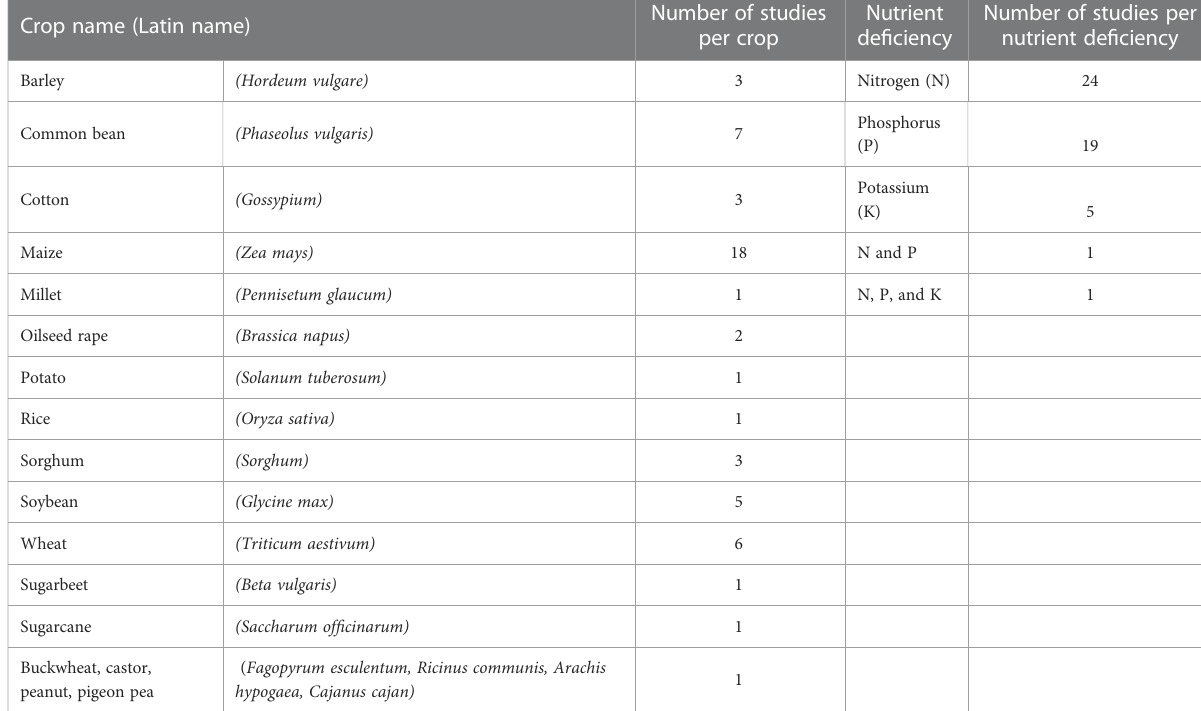
TABLE 1 Number of studies per category at fi eld-scale used for the systematic research. Crop name (Latin name)